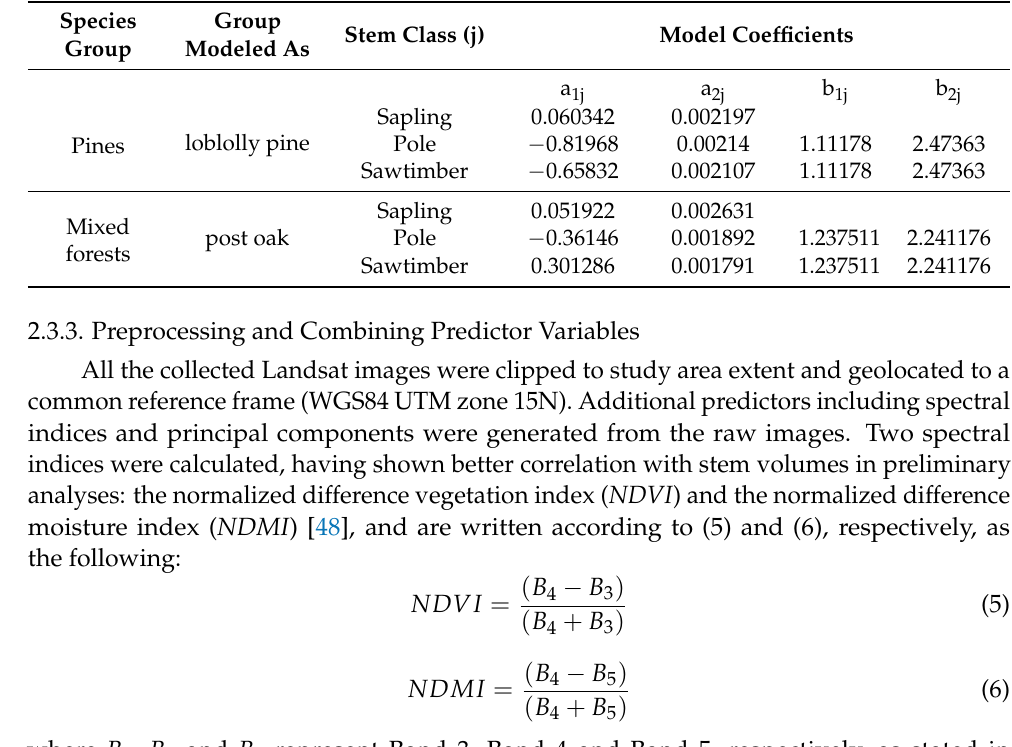
Table 1. Coefficients to compute sapling, pole and sawtimber total stem volume stump to